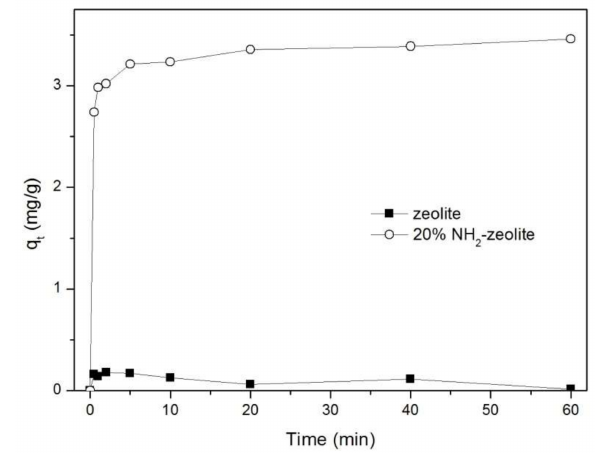
Figure 7. Adsorption properties of zeolite and 20% amino functionalized zeolite sample towards chromate ions at different adsorption